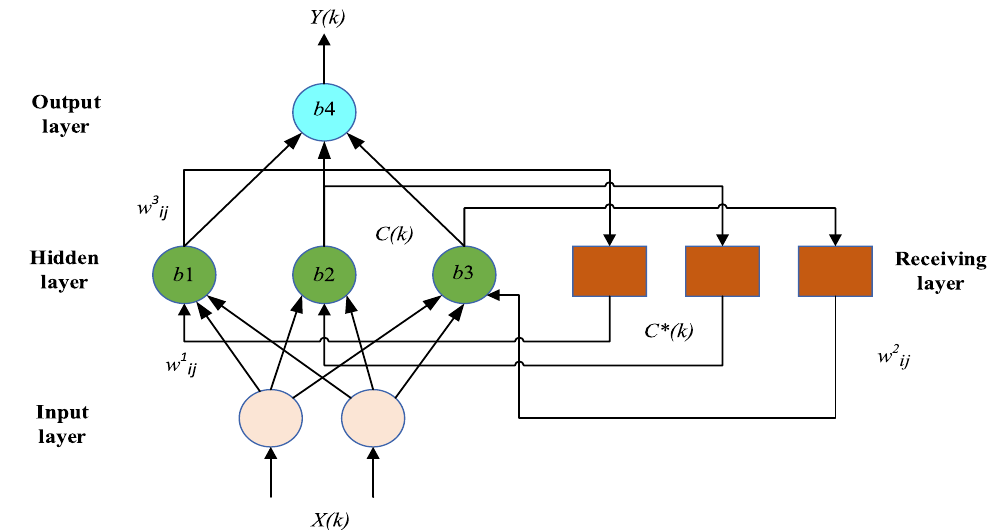
Fig. 9 Elman neural network structure with two input units, three hidden units and one output